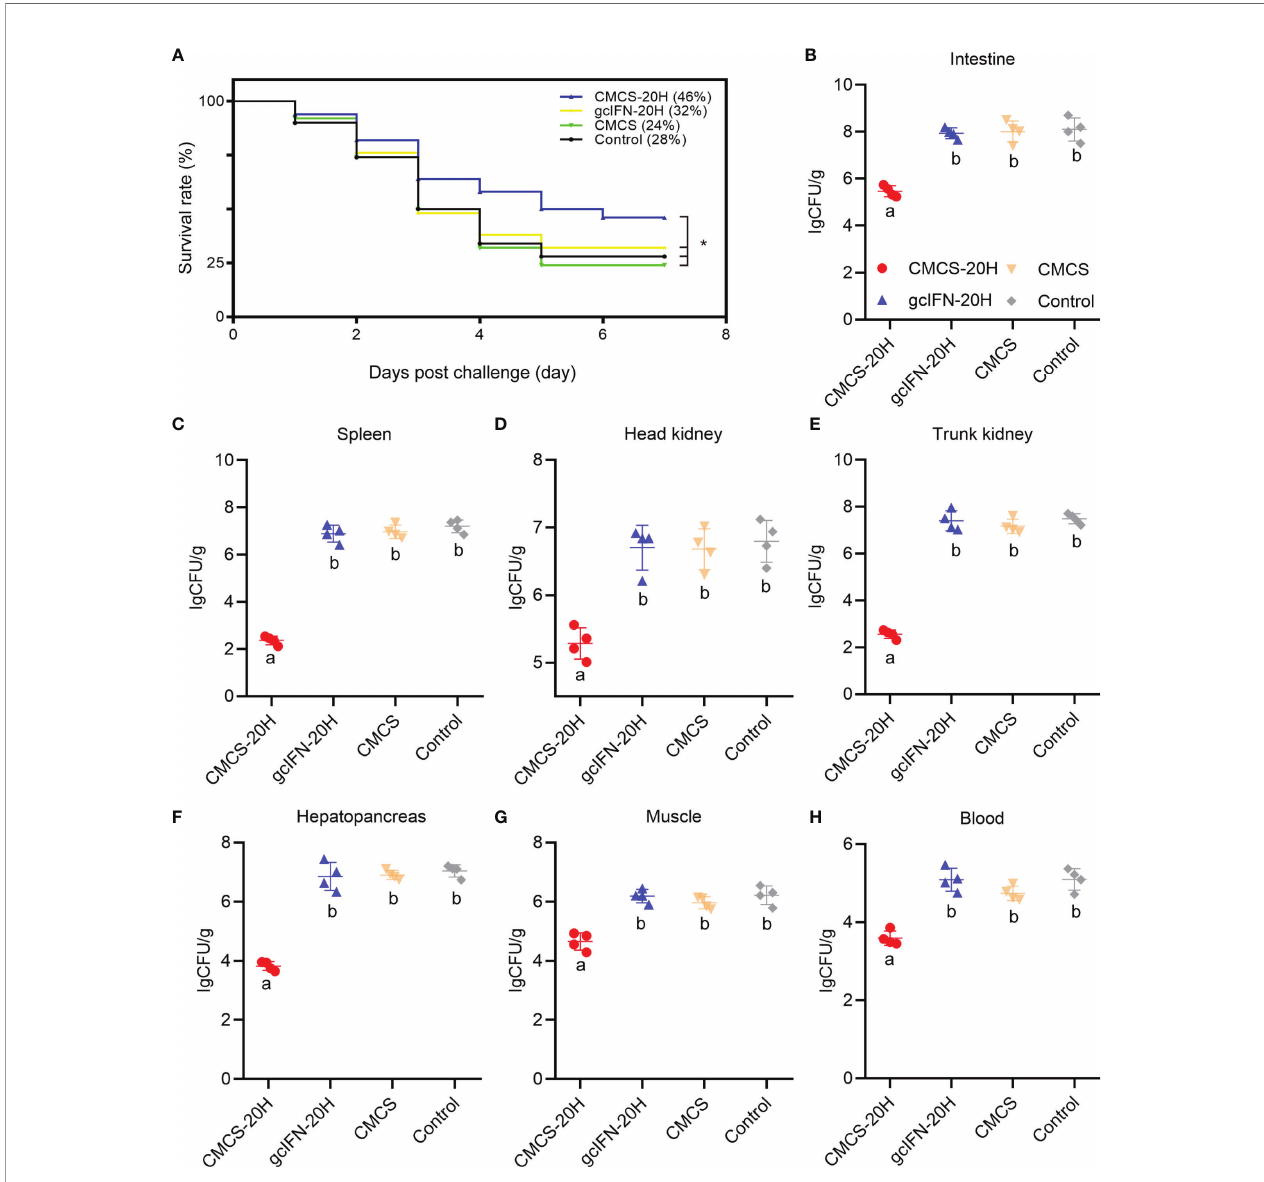
FIGURE 4 | The survival rate and tissue bacterial load in grass carp post -A. hydrophila infection. (A) Survival rate was monitored and calculated for 7 days. (B – H) The content of A. hydrophila in each tissue (intestine, spleen, head kidney, trunk kidney, hepatopancreas, muscle, blood) in infected grass carp in each treatment group ( n = 50). Samples were taken at 72 h postchallenge. Data are presented as means ± SD ( n = 4). Different lowercase letters in each group (a and b) denote signi fi cant variations suggested by the Kruskal-Wallis statistics followed by the Dunn ’ s multiple comparison (p < 0.05). p values were calculated by Log-rank (Mantel- Cox) Test. * denotes signi fi cant variation (p <